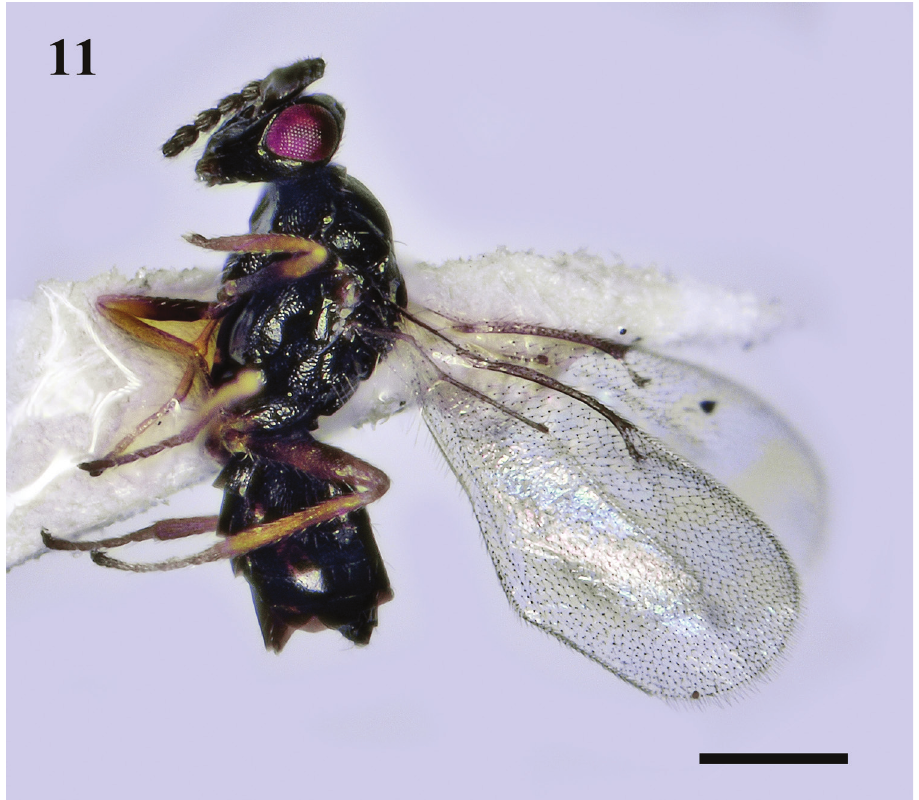
Figure 11. Holcotetrastichus rhosaces (Walker), female, habitus, lateral view. Scale bar: 500